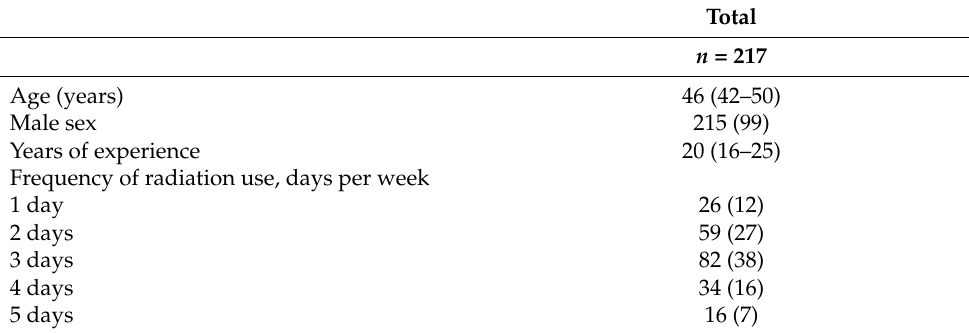
Table 1. Background characteristic of the